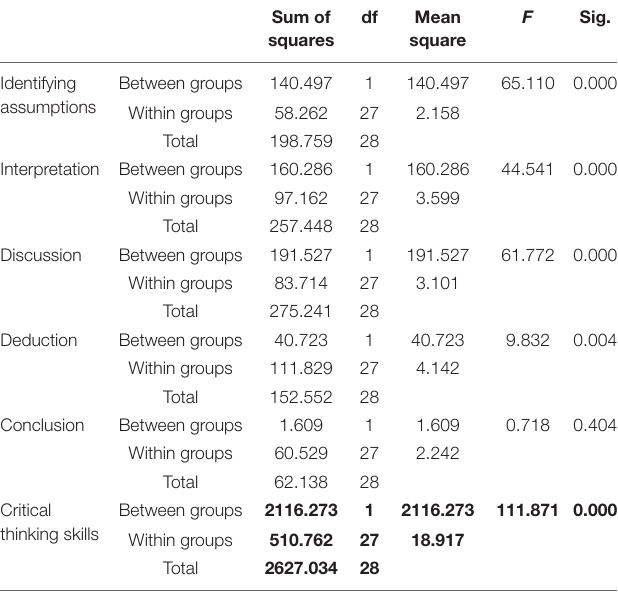
TABLE 6 | Analysis of variance (ANOVA) results of the critical thinking